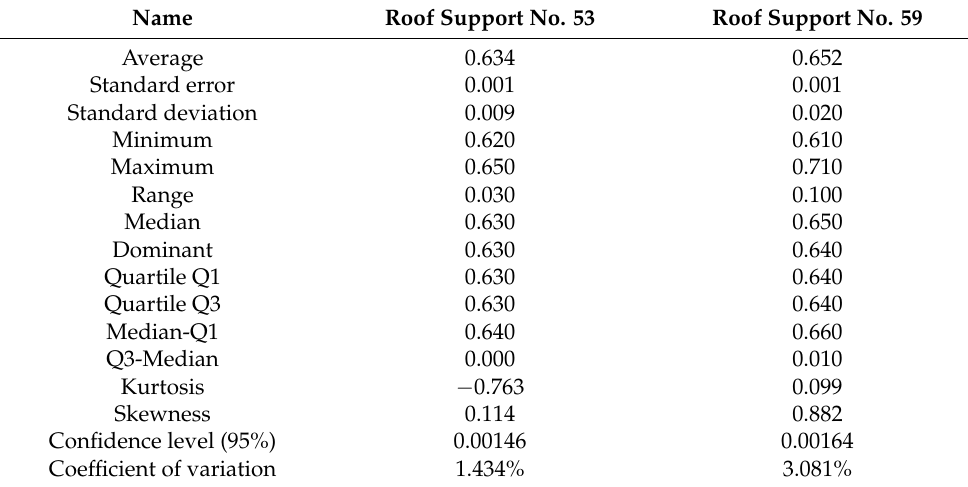
Table 1. Summary of the calculations used to present a box-and-whisker diagram for the tip-to face